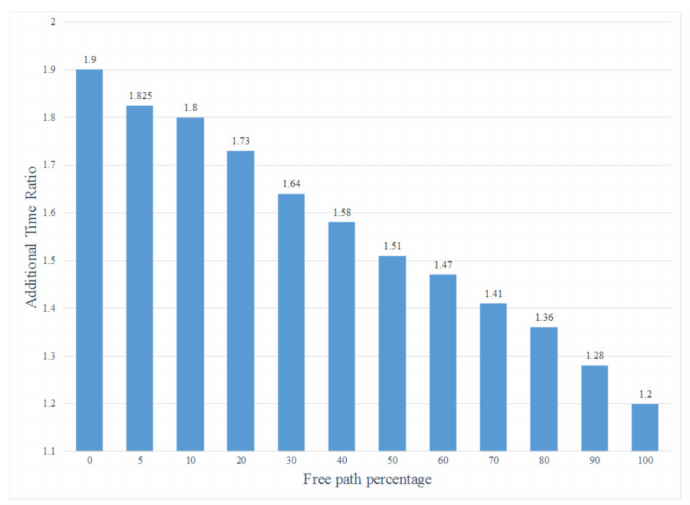
Figure 9. The e ff ects of free path choice on average traveled time.